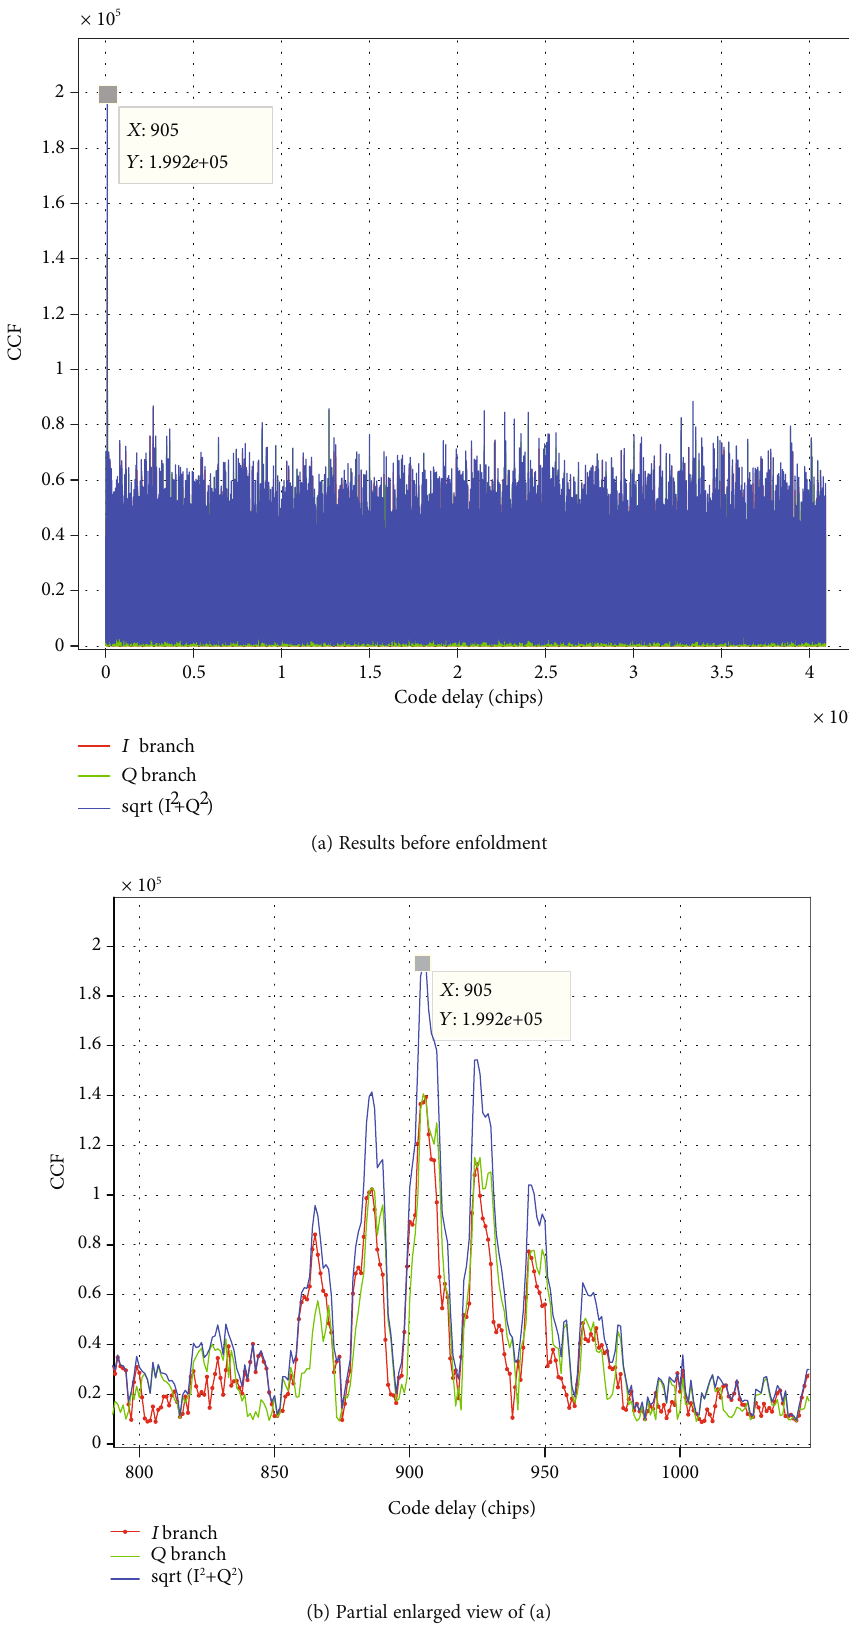
Figure 9: Results of the correct